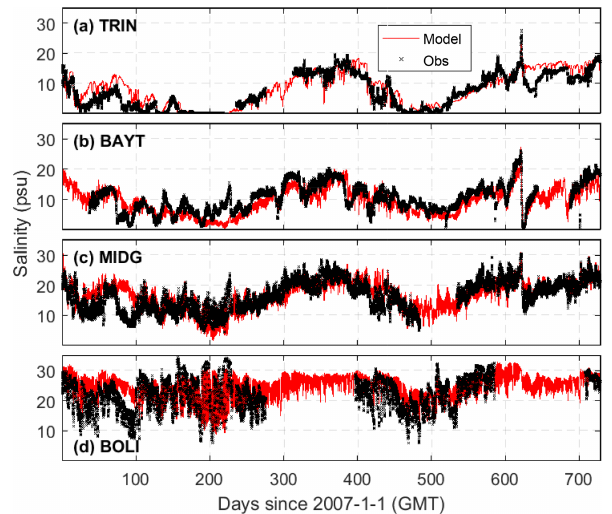
Figure 4. Salinity comparison between the model (red line) and observations (black cross) at four TWDB stations (see Fig. 2 for their